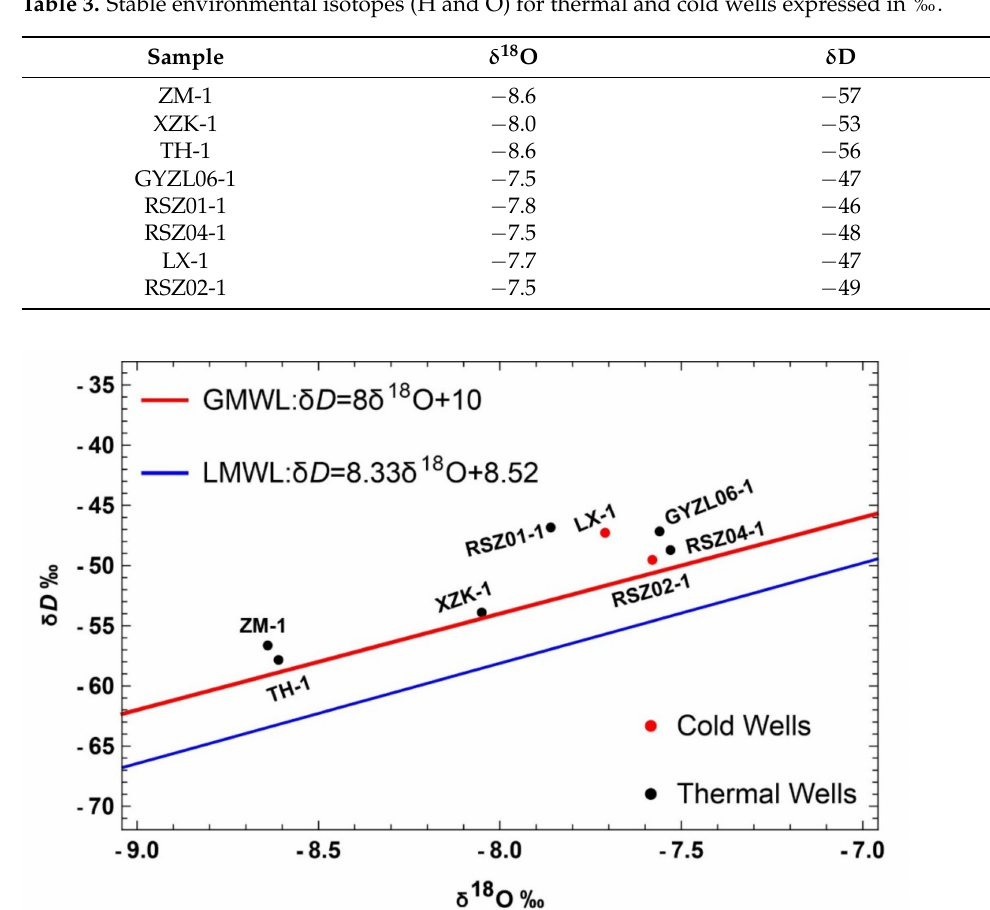
Figure 4. Plot of H and O isotopes of thermal and cold well samples. No water samples fall below the meteoric water lines, indicating no evaporation and oxygen-18